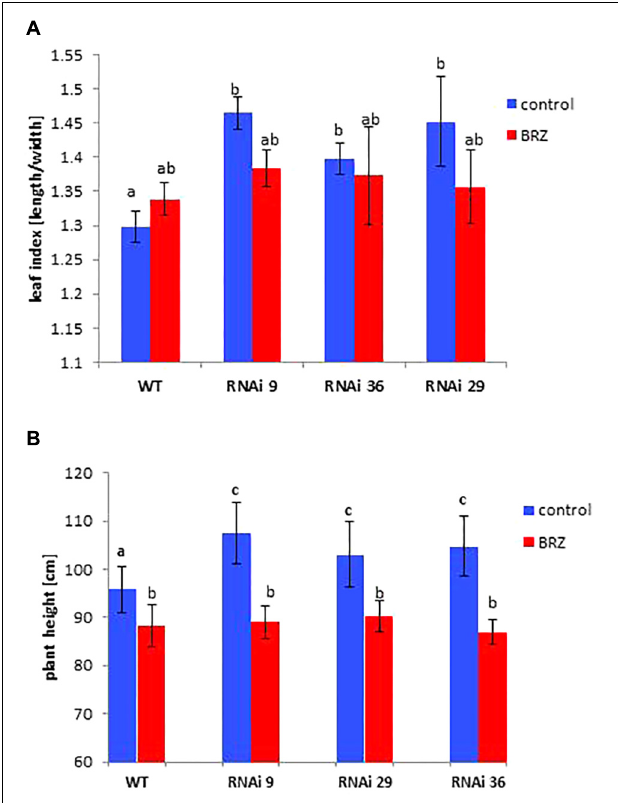
FIGURE 3 | Rescue of the phenotypic changes of NtMSBP1 -RNAi tobacco plants. (A) Shown are mean values and standard deviations of the ratios between leaf length and width (leaf index) and of (B) total plant of WT plants and MSBP1 -RNAi tobacco lines 4–6 replicates). Leaves were locally treated with 1 µ M BRZ or not. Significant differences according to a one-way ANOVA are indicated by different letters ( α = 0.05).